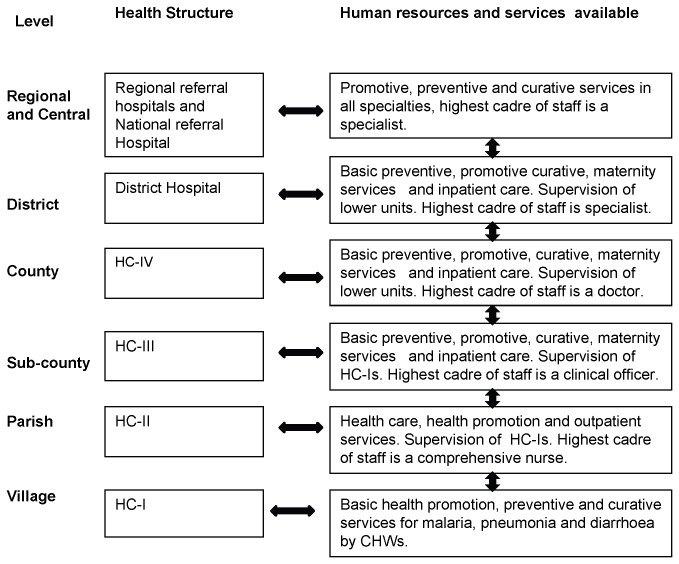
A diagrammatic depiction of the health system hierarchy in Uganda.